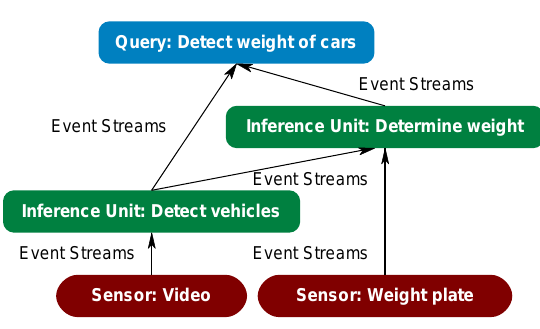
Figure 4. Semantic Streams query.